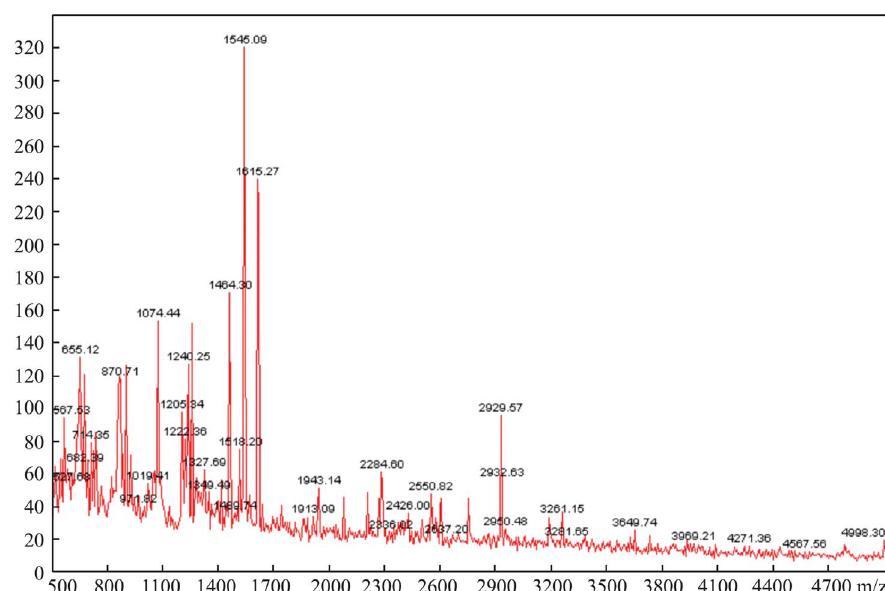
Figure 2. MALDI-TOF MS spectrum of the peptide profile using C4 resin.